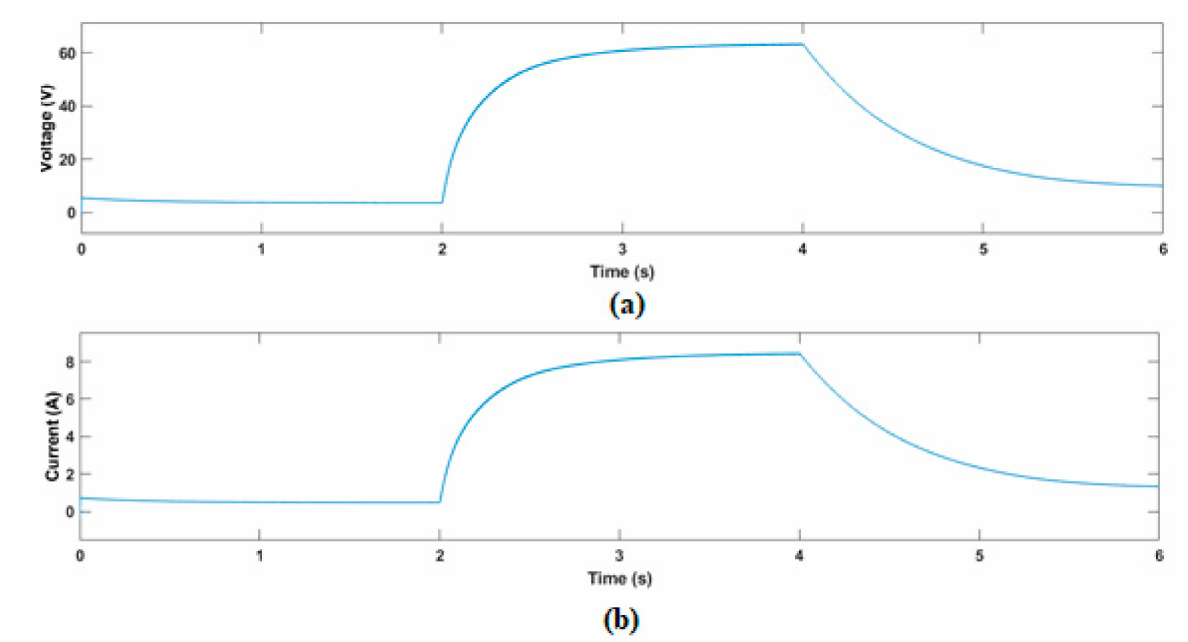
Figure 28. SEPIC converter outputs ( a ) voltage and ( b ) current for variable speed. Now, in deceleration mode, the SC SOC charge is increased from duration 2 s to 3.9 s and the speed goes on decreasing and does not need any power due to inertia in this route until acceleration occurs as presented in Figure 29a,b.